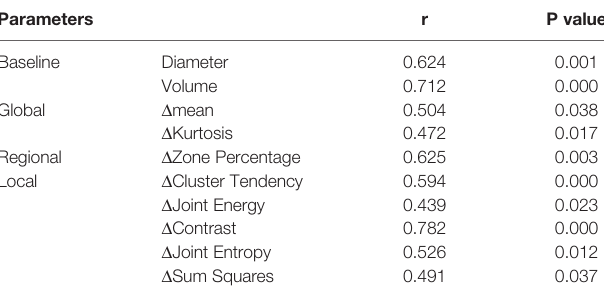
TABLE 3 | The relationships between tumor response (Rvisu) and quantitative features.